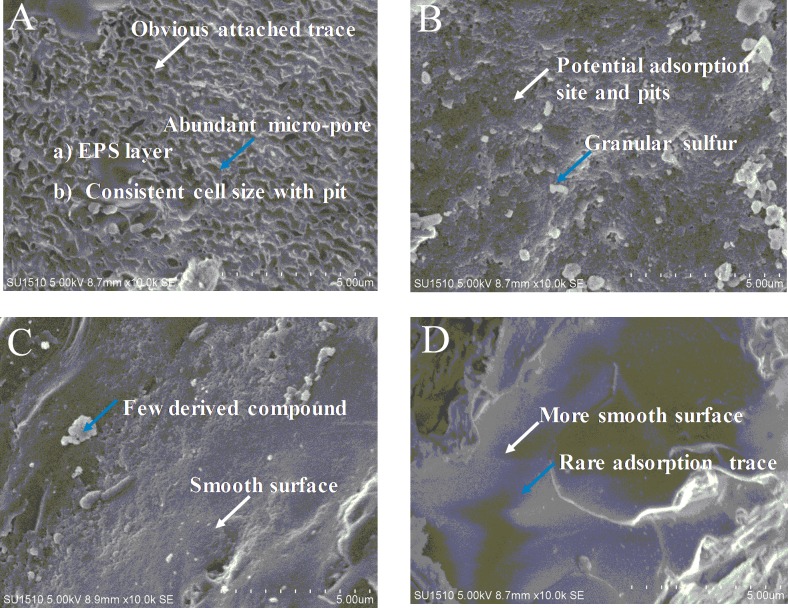
Morphological surface differences of the ore samples between the different bioleaching systems: (A): BC; (B): PD; (C): AD; (D) ED. The slag was dried at room temperature in a vacuum desiccator and observed via scanning electron microscopy at 10× k magnification (bar, 5 μm, 10× k).